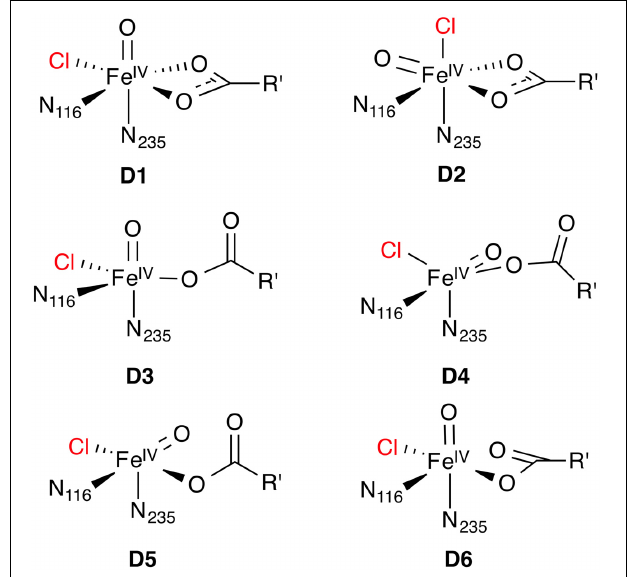
FIGURE 7 | Possible isomeric structures of the 5 [Fe IV = O] species D; R (cid:2) = (CH 2 ) 2 COO −